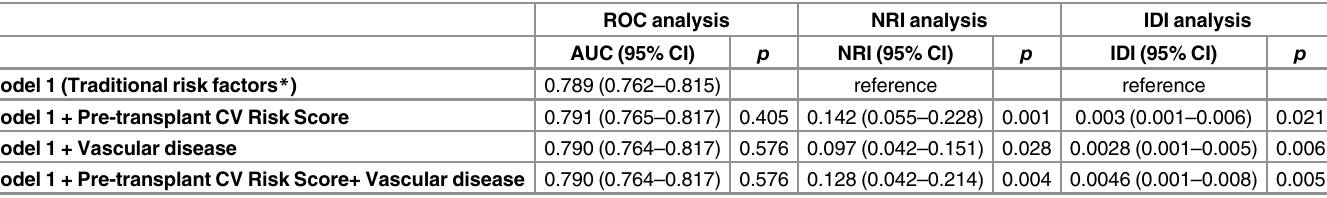
Table 5. Incremental value of pre-transplant CV risk score or vascular disease over traditional risk factors for predicting allograft